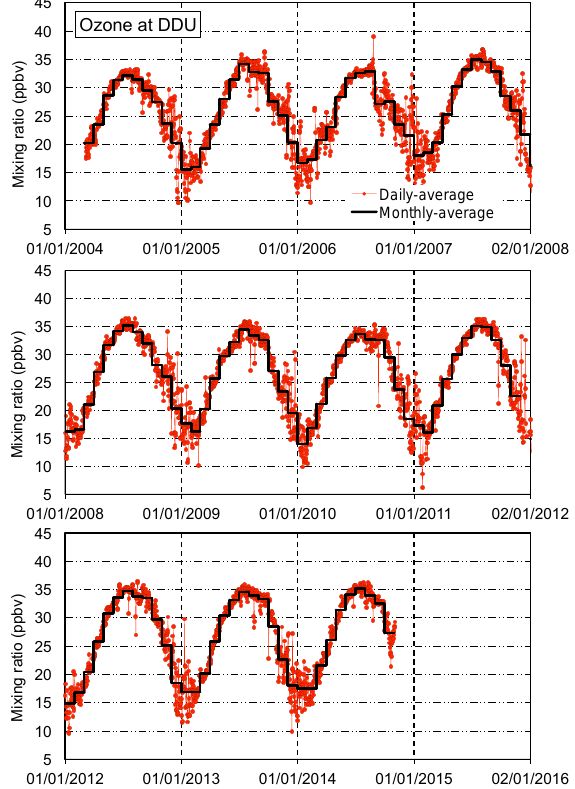
Figure 3. Daily averaged (red points) and monthly averaged (solid black line) surface ozone mixing ratio at Dumont d’Urville from March 2004 to October